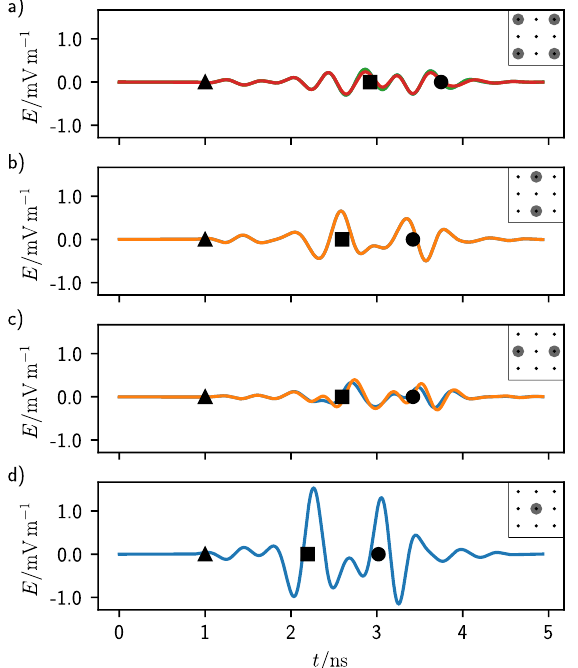
Figure 4. Calibrated waveforms B n for a 3 cm deep target at 1 GHz central frequency and a 3 × 3 antenna grid. The black triangle, square, and circle represent, in order from left to right, the middle time of the pulse excitation and the return time for the first and second interface of the target. ( a ) Waveforms for the corner antennas. ( b ) Waveforms for the top and bottom central antennas. ( c ) Waveforms for the left and right central antennas. ( d ) Waveform for the central